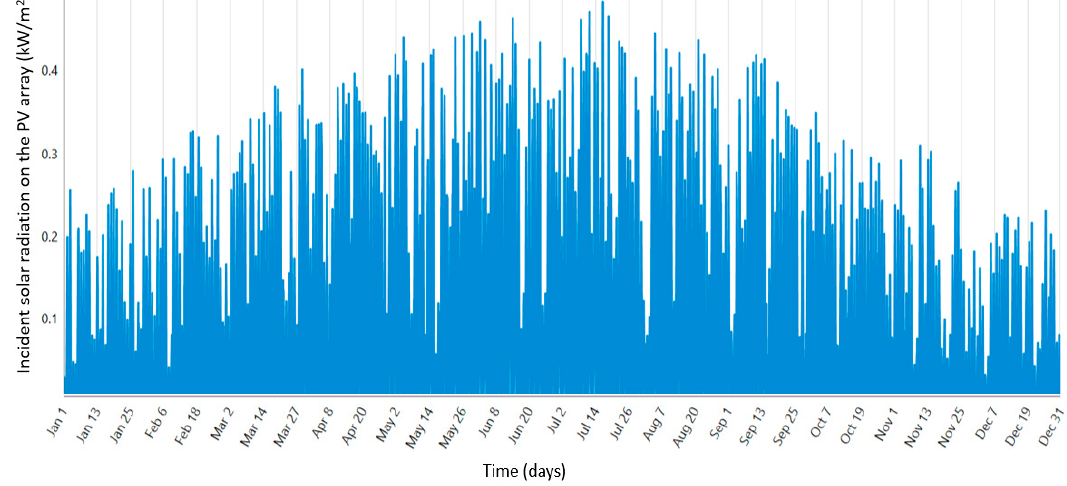
Figure 16. Solar radiation potential available in the location.